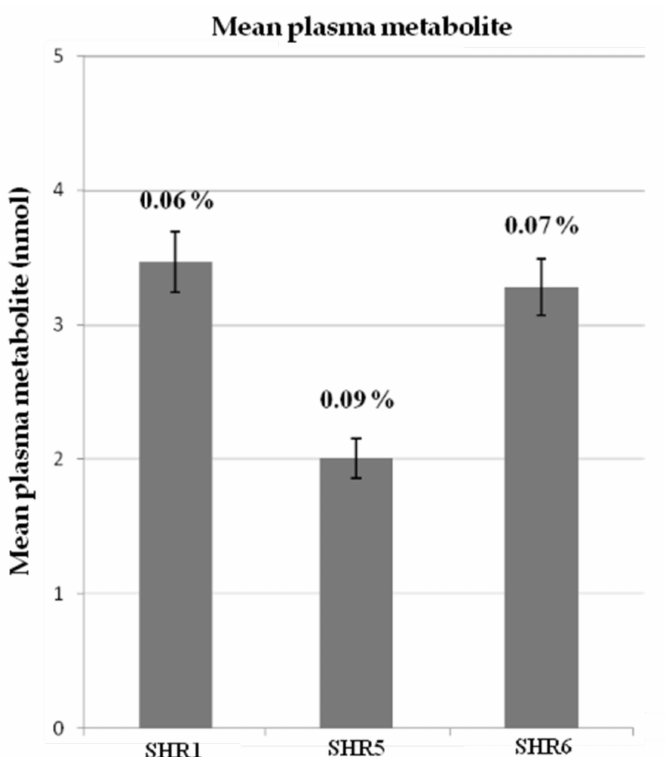
Figure 3. Mean plasma metabolite levels in different experimental group at day 7, 4 h after ingestion of grape pomace extracts (p < 0.05 ) and their respective recoveries (%). Data expressed as nmol ± standard deviation. SHR rats fed with: SHR1, Grenache (GRE1) EA70 seed pomace extract; SHR5, Mourv è dre (MOU) EA70 skin pomace extract and SHR6, Alicante (ALI) EA70 skin pomace extract. SHR5 urinary excretion indicated substantial absorption of polyphenols (4.41% of intake)